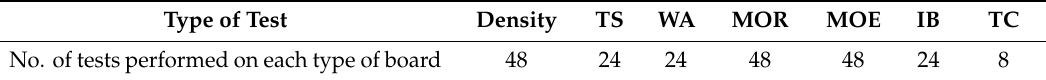
Table 2. Number of tests performed on each type of board. TS, thickness swelling; WA, water adsorption; MOR, modulus of rupture; MOE, modulus of elasticity; IB, internal bond or tensile strength; TC, thermal